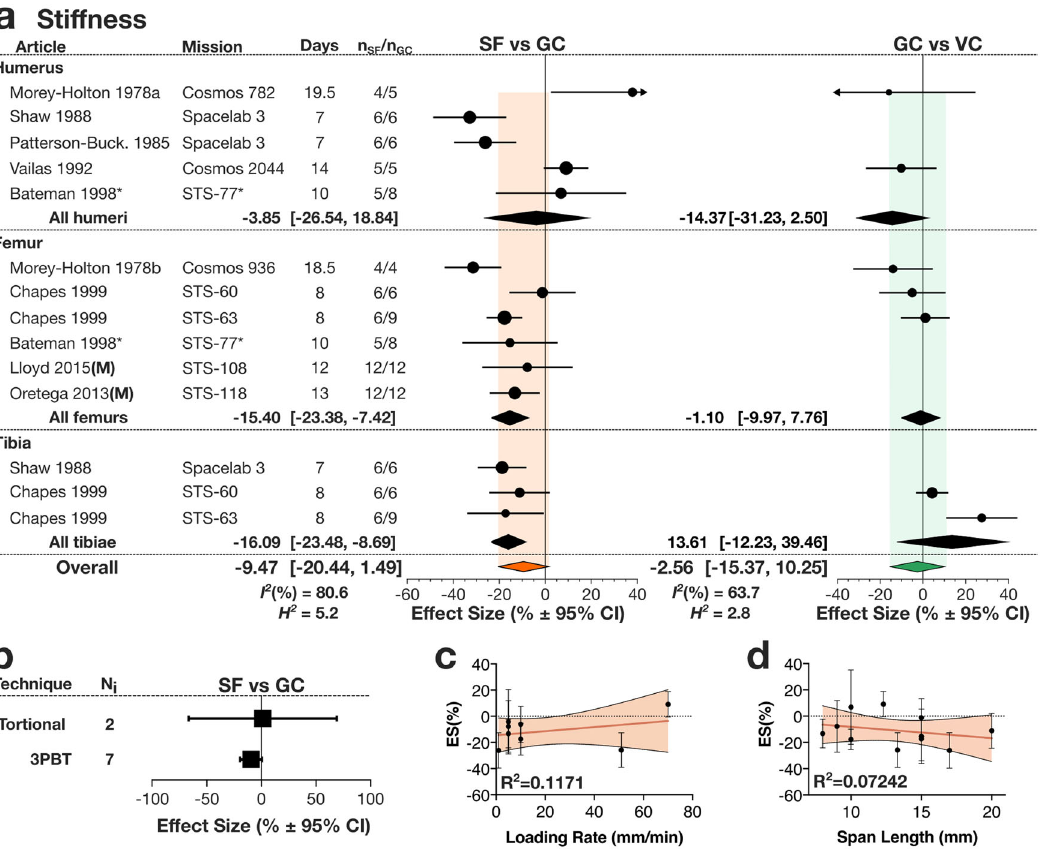
Fig. 3 Space fl ight-induced changes in bone stiffness in rodents. a Forest plot of changes in stiffness in humerus, femur and tibia in space fl ight animals (SF) compared to ground control (GC) ( Left ); and GC compared to vivarium control animals (VC) ( Right ). Missions are ordered by mission year; mission name, duration (Days), SF and GC sample sizes (n SF /n GC ) are shown. Circle/line: effect size (%) and 95% CI, the size of the circle is proportional to the mission ’ s weight. Black diamonds : overall effect size and 95% CI for rats; color diamonds : overall effect size and 95% CI for rodents. I 2 and H 2 are for rodents. *indicates missions where there was no GC, and SF was compared to VC. b Subgroup analysis of measured bone stiffness by mechanical test: torsional test (Torsional) and 3-point bending tests (3PBT). Square/line: effect size (%) and 95% CI. N i: number of mission level outcomes. Meta-regression analysis of stiffness measures obtained by 3PBT as a function of loading rate ( c ) and span length ( d ) of the 3PBT machinery. Linear regression line ( dark blue ), its 95% CI ( light blue area ) and R 2 are shown.